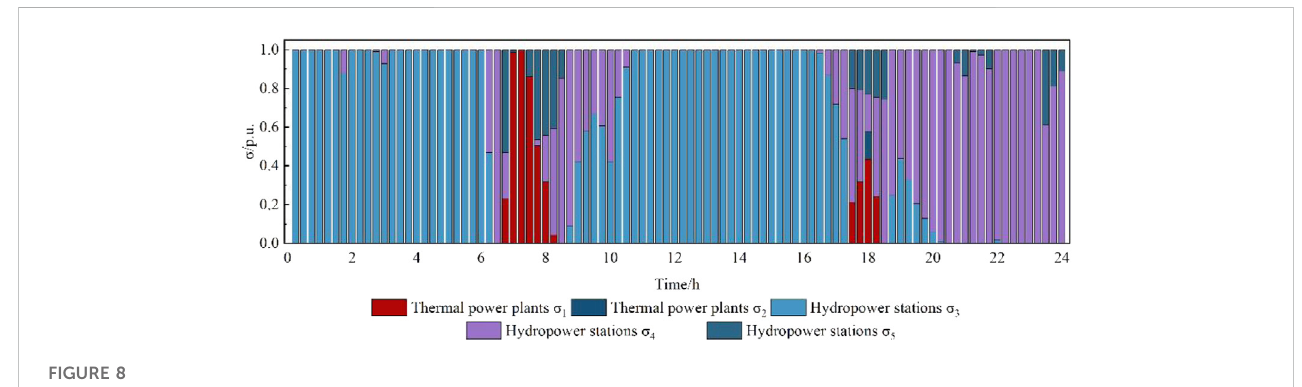
FIGURE 8 Intra-day optimization results of σ on July 1.